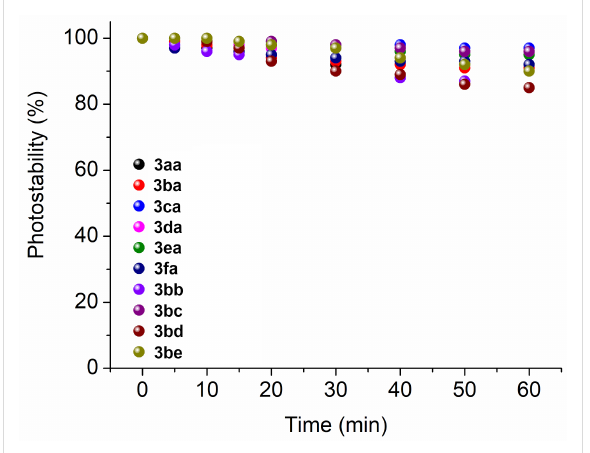
Figure 6: Photostability (%) plots of derivatives 3aa – fa and 3bb – be in DMSO solution after irradiation with white-light LED array system